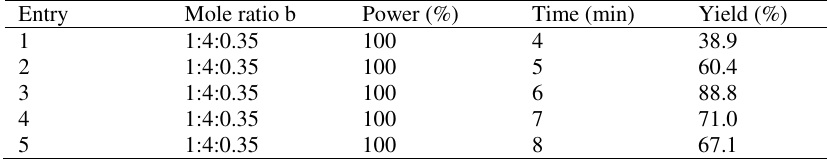
Table 6 Change the reaction time under microwave irradiation